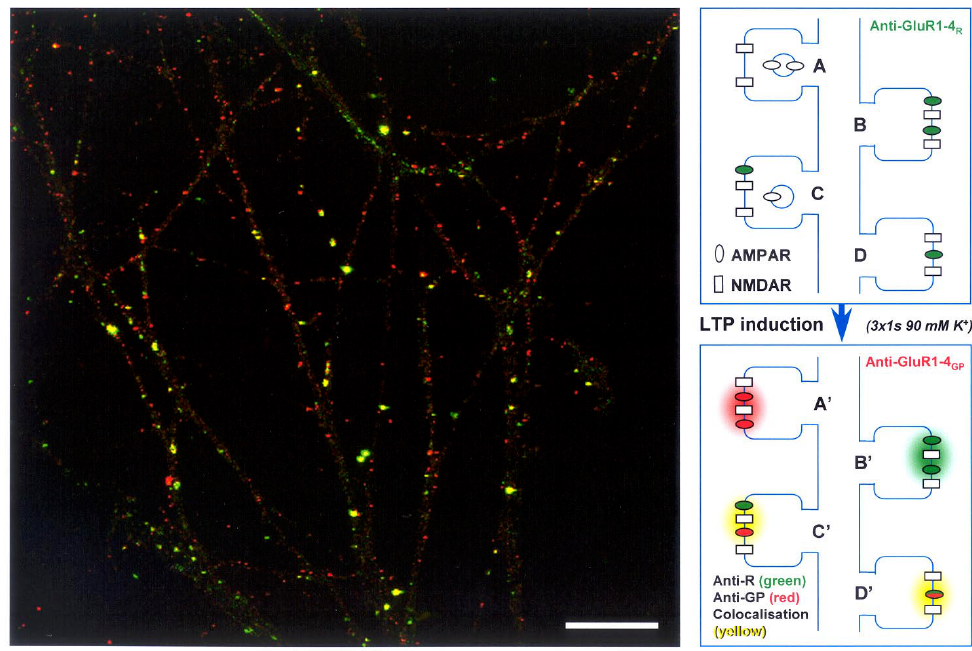
FIGURE 2. Changes in AMPAR expression on the surface of living hippocampal neurons following LTP induction. Site-directed antibodies that recognise an extracellular region of all AMPAR subunits (GluR1–4) were used for the immunolabelling of living neurons. These antibodies were raised in two species (rabbit: Anti-GluR1–4 R ; and guinea pig: Anti-GluR1–4 GP ) to enable sequential immunofluorescent labelling of individual living neurons before (green and yellow) and after (red) the induction of LTP by using 3 × 1 s exposure to 90 m M K + . Sequential immunolabelling revealed the appearance of new AMPAR clusters (red) at sites on the neuronal surface that lacked AMPARs prior to LTP induction. Right panels schematically illustrate the colocalisation (yellow) of anti-GluR1– 4 R (green) and anti-GluR1–4 GP (red) immunoreactivity on the surface of hippocampal neurons. In the lower right panel the possible results of an LTP experiment are illustrated: (A’) newly surface-inserted receptors labelled only with the anti-GluR1–4 GP following LTP induction (red); (B’) receptors labelled prior to LTP induction with the anti-GluR1–4 R antibody (green); (C’) anti-GluR1–4 R or anti-GluR1–4 GP labelled receptors in close proximity (yellow).; and (D’) previously anti-GluR1–4 R labelled AMPARs that are relabelled with the anti-GluR1–4 GP (yellow). The appearance of new AMPAR clusters was NMDAR-dependent, since it was antagonised by the application of NMDAR antagonists (not shown). Scale bar 20 µ m. See[70,71] for detailed description of these